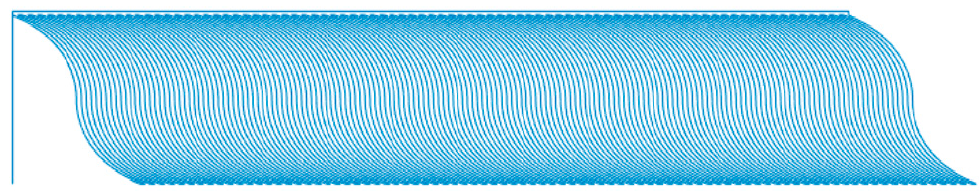
Figure 6. The curve path created in a layer using computer code, with a start and end angle of 70° and a middle angle of 0°.